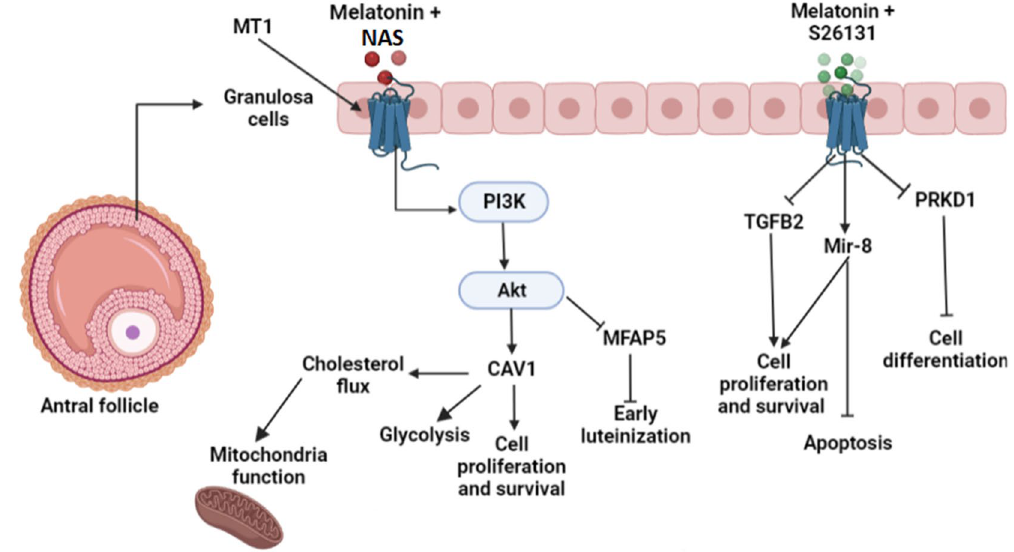
Figure 1. Effects of MT1 receptor activation or knockdown on the response of human granulosa cells to melatonin (generated by BioRender, https:// biore nder.